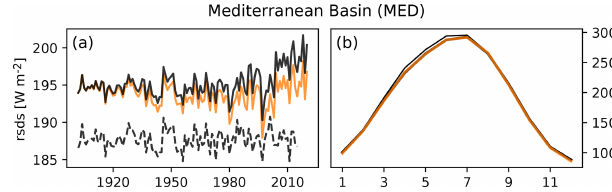
Figure 8. Same as Fig. 7 but for shortwave radiation over the Mediterranean Basin (MED).